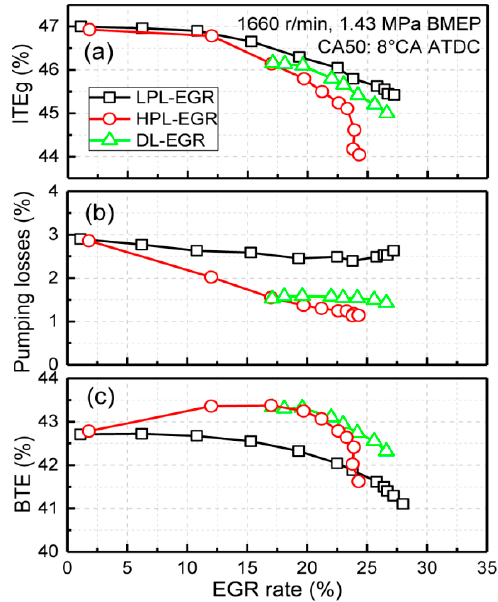
Figure 9. ( a ) Indicated thermal efficiency, ( b ) pumping losses, and ( c ) brake thermal efficiency at different EGR ratios [128].